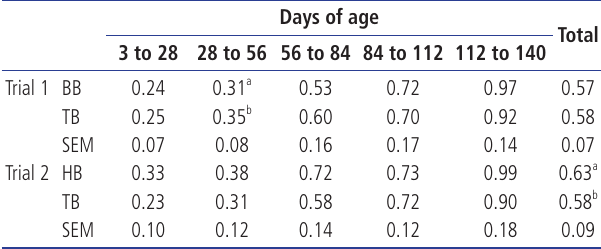
Table 4. Least square means of average daily gain of Berkshire purebreds (BB) and crossbreds sired by Hereford (HB) and Tamworth (TB)